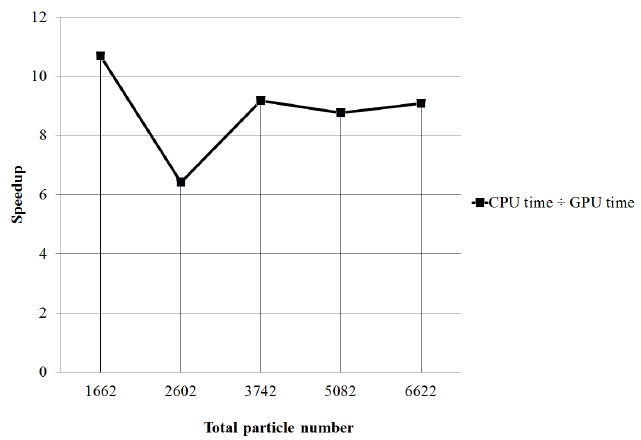
Fig. 14: Speedups of the GPU version over the CPU version